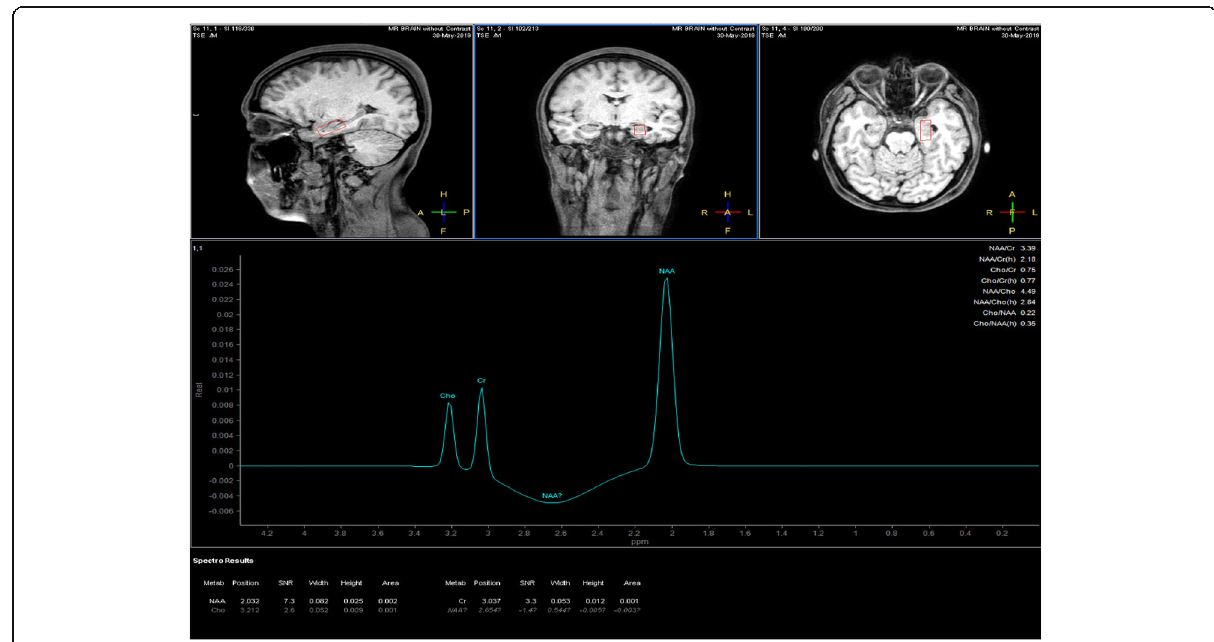
Fig. 1 The location of MRS voxel with a representative spectrum in the left hippocampus